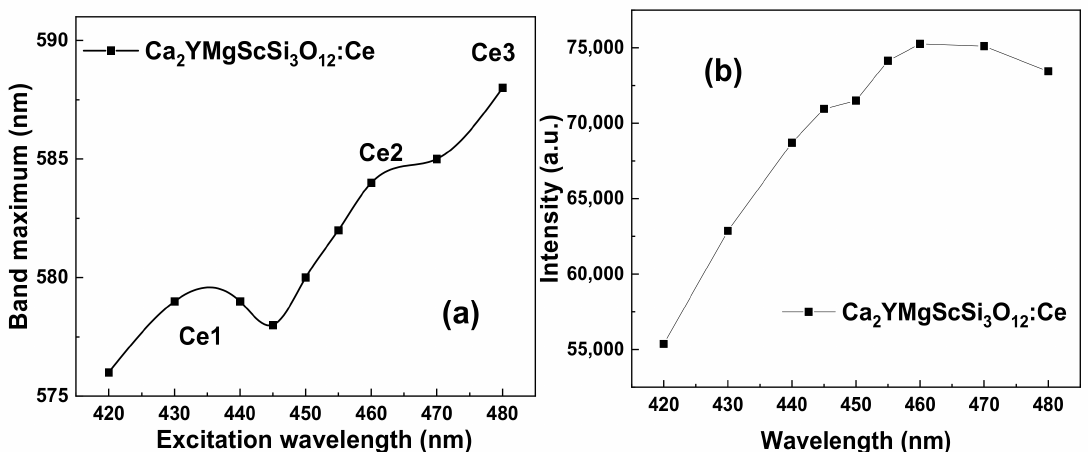
Figure 8. Dependencies of the maxima ( a ) and intensities ( b ) in the peak positions of Ce 3+ emission bands on excitation wavelength in Ca 2 YMgScSi 3 O 12 :Ce MPs (see Figure 7a,b). The normalized excitation spectra of the Ce 3+ luminescence in the Ca 2 YMgScSi 3 O 12 :Ce MP samples are shown in Figure 7b. In these spectra, the most intensive excitation bands, E 1 and E 2 , peaked in the 454 nm (E 1 ) and 353 nm (E 2 ) ranges, are attributed to the intrinsic transitions from the 4f( 2 F 5/2 ) level of the ground state to the 5d (E 2 ) excited level of the Ce 3+ ions (Table 4). The excitation bands peaked at 306 nm (B 1 band) and 274 nm (B 2 band) are also observed in the excitation spectra of the Ca 2 YMgScSi 3 O 12 :Ce MPs (Figure 7a,b). These excitation bands are not related to the intrinsic transitions of the Ce 3+ ions and probably correspond to the Ce 3+ luminescence excitation by the emission of the defect centers or the emission of flux-related impurities [30,31]. Table 4. Spectral characteristics of the different Ce 3+ multicenters in Ca 2 YMgScSi 3 O 12 :Ce garnet. Type of Centers